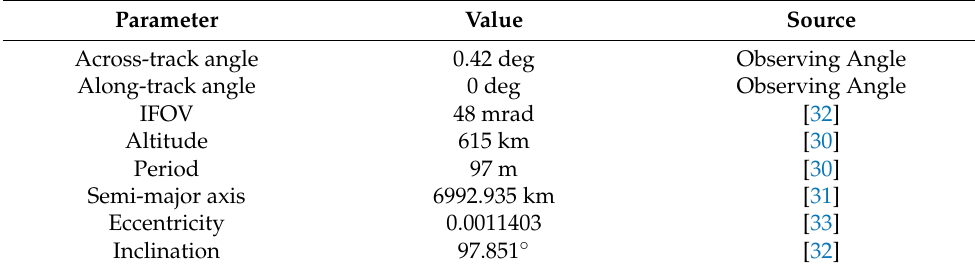
Table 3. Orbital and image information required for “Read Generic Image File” function. Parameter Value Source Across-track angle 0.42 deg Observing Angle Along-track angle 0 deg Observing Angle IFOV 48 mrad [32] Altitude 615 km